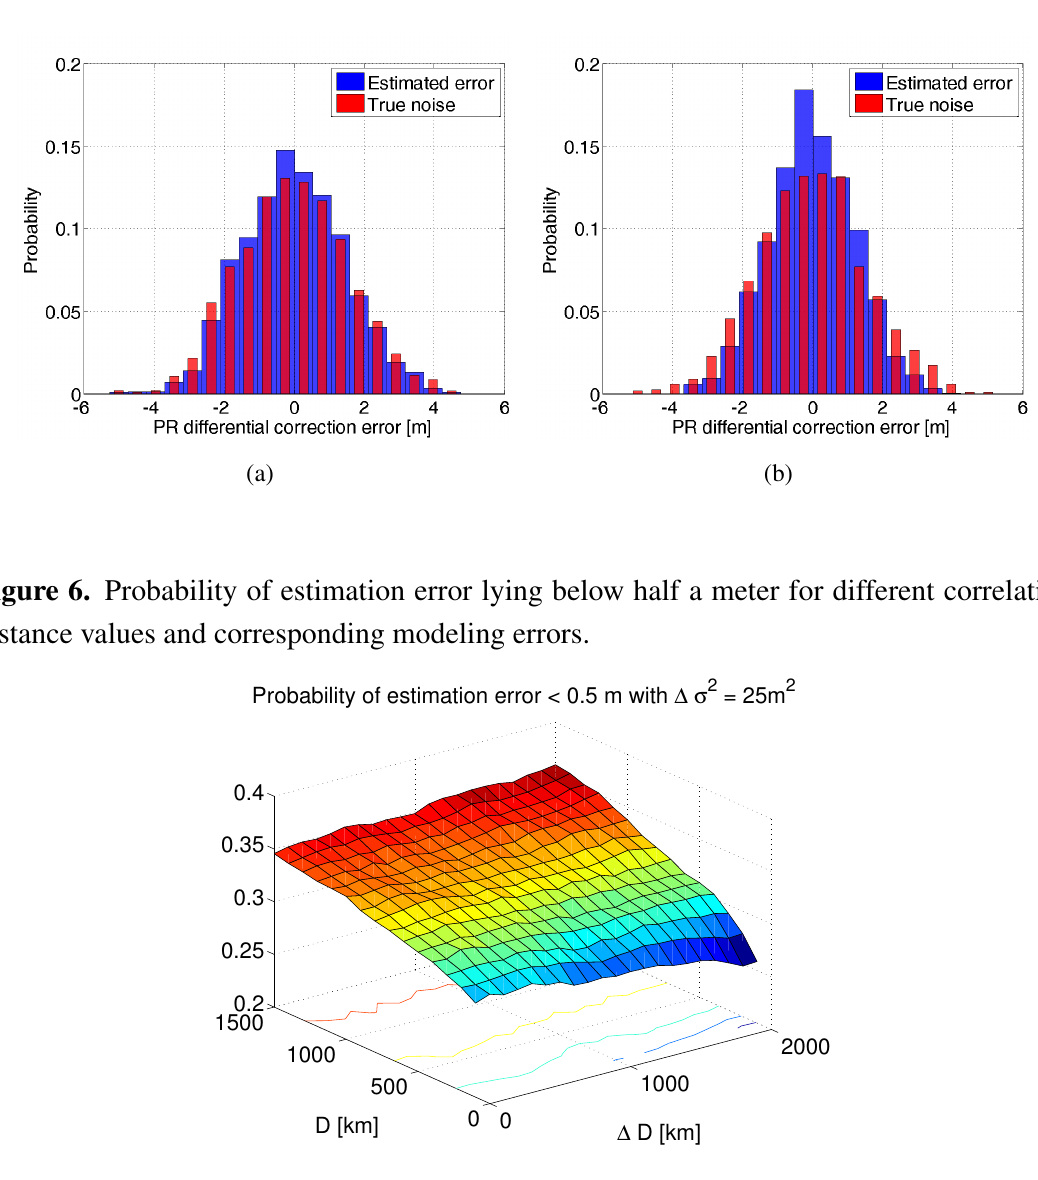
Figure 5. Superimposed histogram of estimation error and true error distributions for a single combination of modeling errors ( a ) ∆ D = 200 km on top of D = 100 km and ( b ) ∆ D = 1800 km on top of D = 900 km.